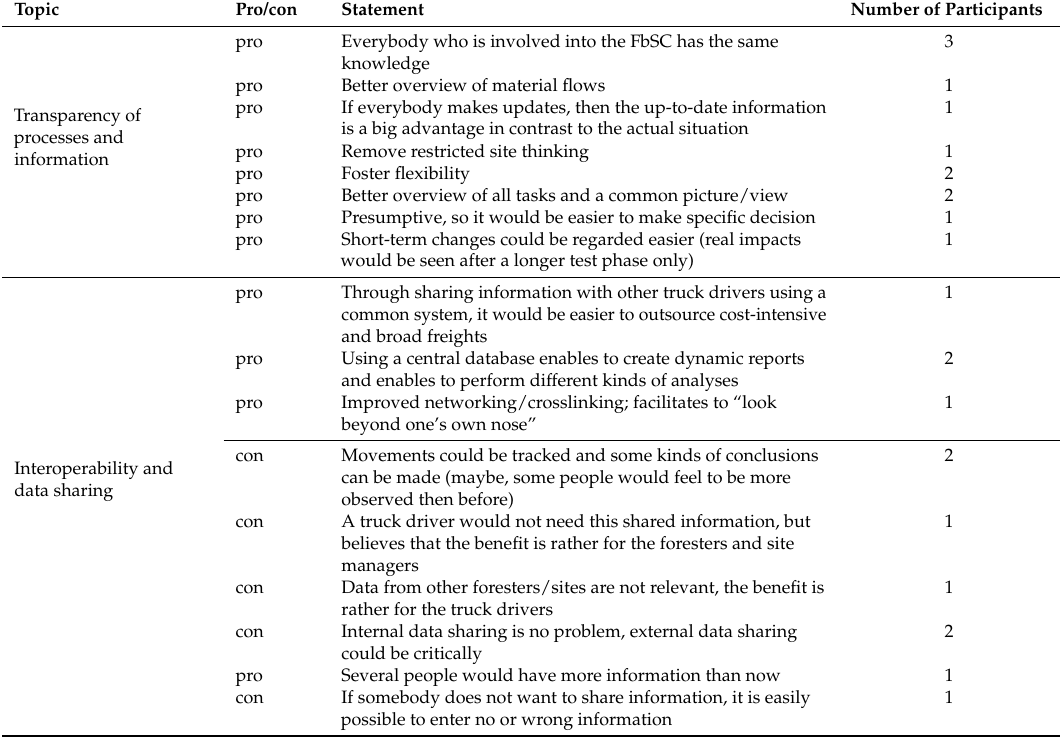
Table A1. Summary of the main qualitative statements of the structured interview (cf. Appendix